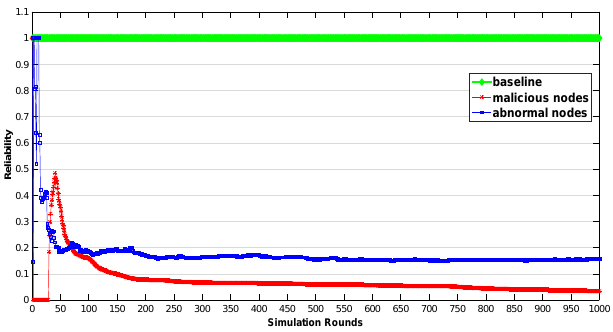
Figure 4. The Reliability Evaluation in 1000 Rounds Consecutive